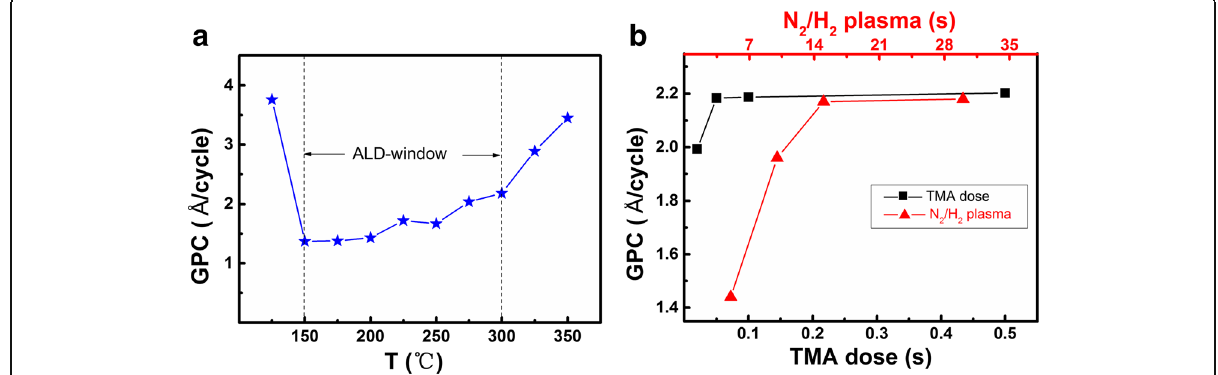
Fig. 1 a Deposition rate of AlN thin films on Si (100) at different temperature. b Precursor saturation curves at 300 °C. Black square represents N 2 /H 2 plasma that was kept constant at 30 s for TMA dose saturation curves. Black triangle represents N 2 /H 2 plasma saturation curve with an optimal TMA dose of 0.05